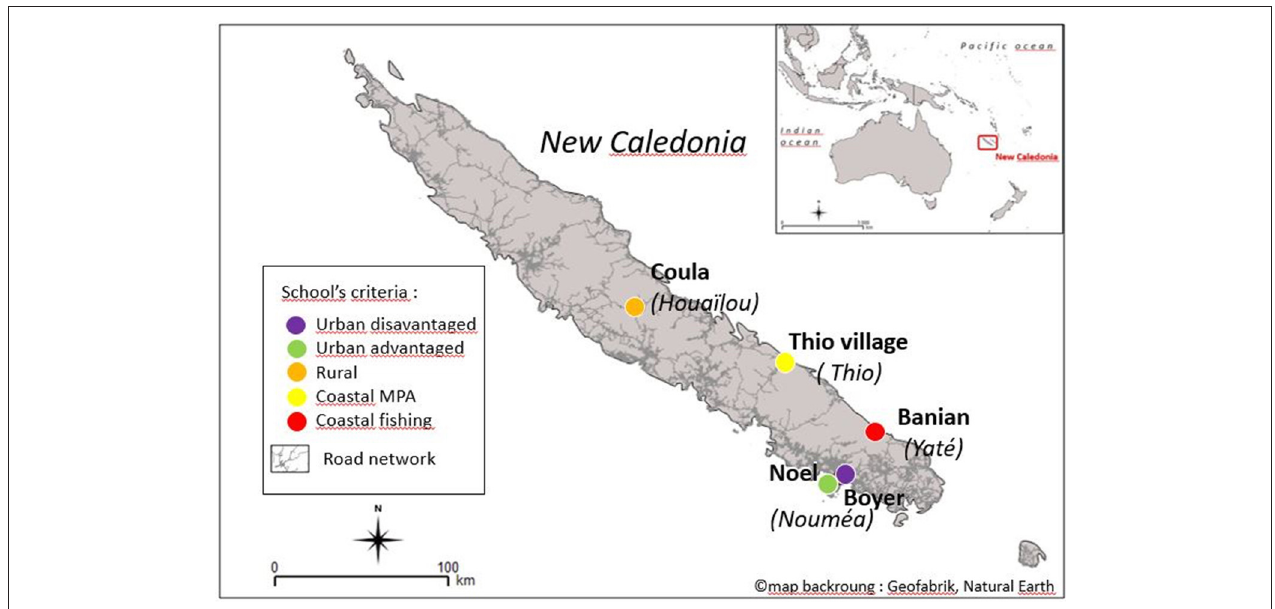
FIGURE 1 | Map of New Caledonia and location of the schools.